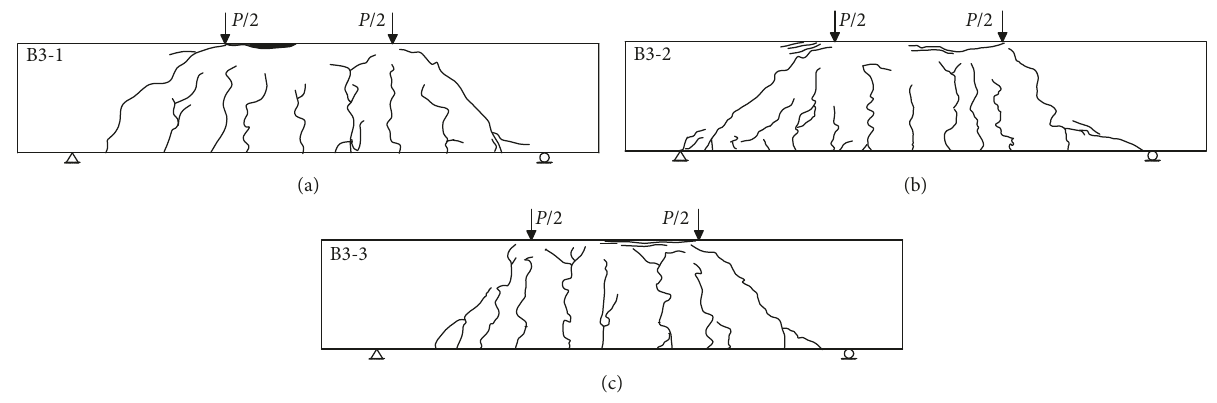
Figure 4: Crack patterns of series B3: (a) B3-1; (b) B3-2; (c) B3-3.